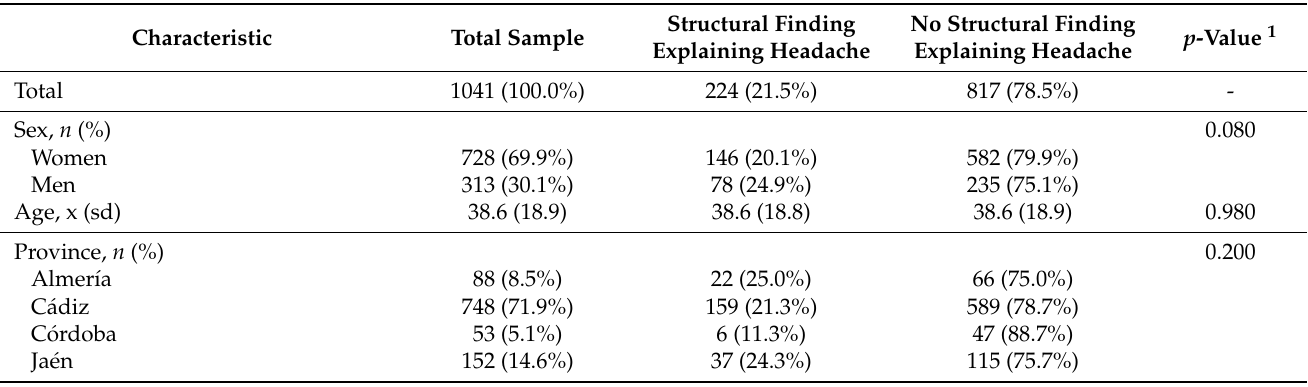
Table 1. Main characteristics of the sample (patients who underwent magnetic resonance imaging due to headache), stratified by the presence of a structural finding that could explain